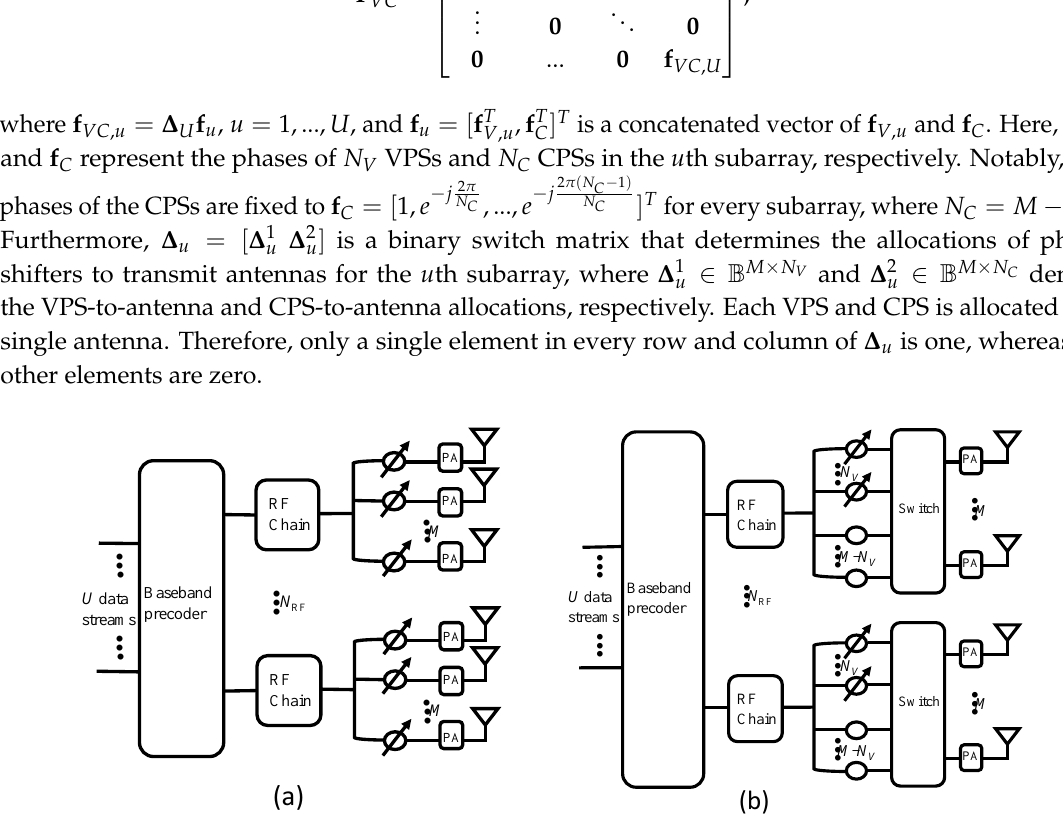
Figure 1. Hybrid precoding for massive multiple-input multiple output (MIMO) systems: ( a ) conventional (PC-HBF architecture; ( b ) proposed partially connected hybrid beamforming (PC-HBF)